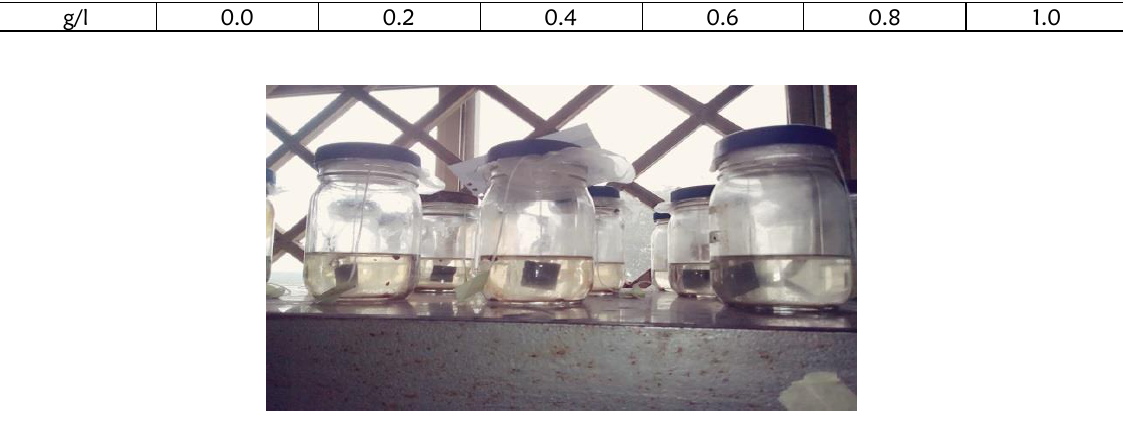
Figure 2: Gravimetric measurements set-up